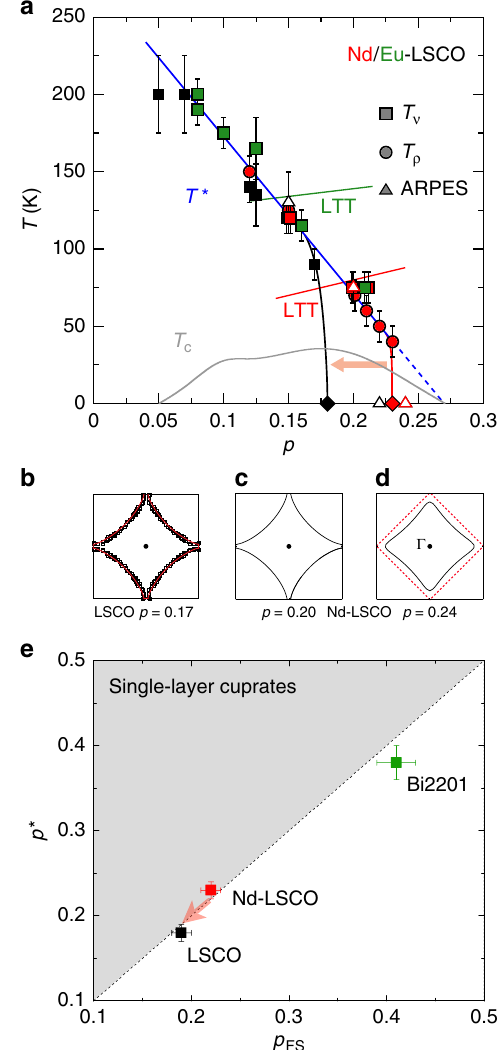
Fig. 1 Phase diagram and correlation between p * and p FS . a Temperature- doping phase diagram, showing the pseudogap temperature T * measured by ARPES (triangles), electrical resistivity (circles) and Nernst effect (squares), in LSCO (black), Nd-LSCO (red) and Eu-LSCO (green) (adapted from ref. 6 ; see references therein). The diamonds mark the critical doping p * at which the pseudogap phase ends at T = 0 (in the absence of superconductivity), for LSCO (black; p * = 0.18, refs. 8,9 ) and Nd-LSCO (red; p * = 0.23, refs. 4,5 ). The short solid lines mark the transition into the low- temperature tetragonal structure (LTT) for Eu-LSCO (green; ref. 36 and Nd- LSCO (red; ref. 34 ), in the interval where it crosses T *. The grey line is the superconducting critical temperature T c of LSCO. The dashed line is a linear extension of the T * line (blue). The red arrow illustrates the effect of applying hydrostatic pressure to Nd-LSCO: it shifts p * down in doping. b , c , d Sketch of the Fermi surface in the fi rst Brillouin zone (frame), as measured by ARPES in LSCO (ref. 11 ) at p = 0.17 ( b ) and in Nd-LSCO (ref. 3 ) at p = 0.20 ( c ) and p = 0.24 ( d ). The red dashed line is the anti ferromagnetic zone boundary (AFZB), which intersects the hole-like Fermi surface of Nd-LSCO at p = 0.20, but not its electron-like surface at p = 0.24. e Correlation between p * and p FS in single-layer cuprates. p *